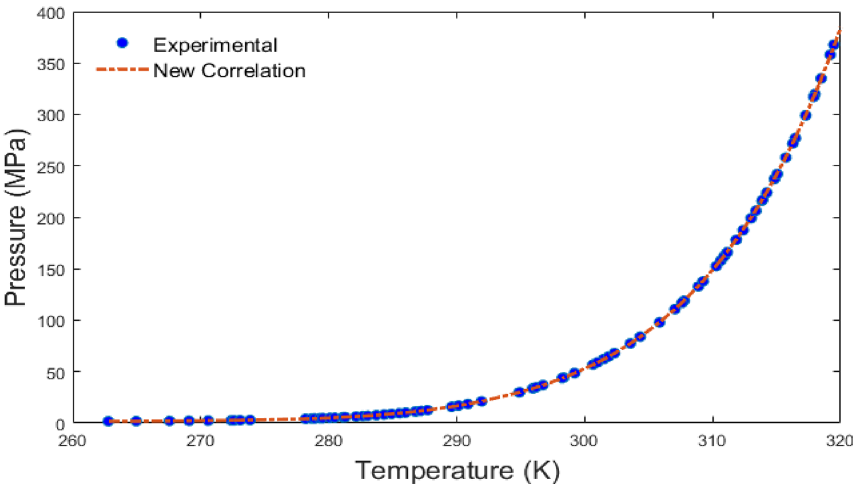
Fig. 14 Peq versus T plot of experimental data (CH 4 hydrates) with “new correla- tion,” AAD = 0.32%